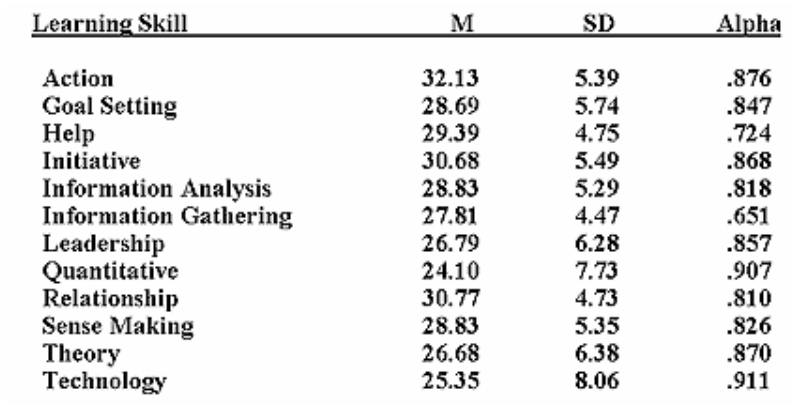
Table 2. Reliability coefficients of the LSP learning